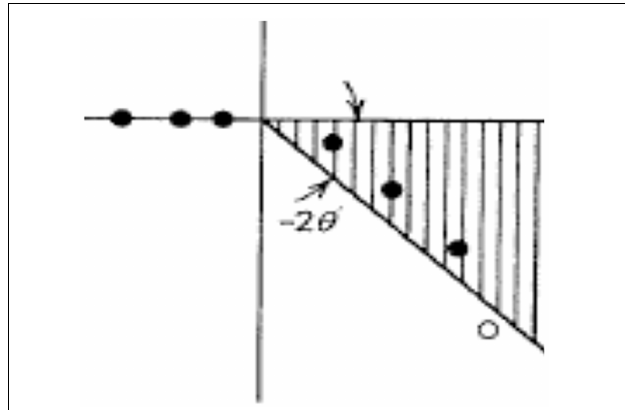
FIGURE 3 | A portrayal of the simple case of the Hamiltonian, H , exhibiting bound states, black dots on the negative real energy axis, with continuous spectrum, σ AC ( H ) , rotated − 2 θ around the origin, displaying a sector, indicated with stripes and arrows, where the resolvent G R ( z ) , Eq. (4) has a meromorphic continuation.